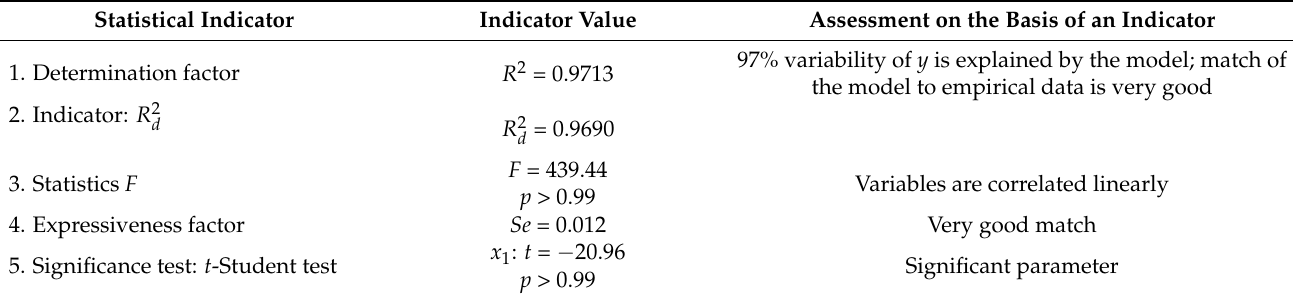
Figure 7. Presentation of the used model (1) and empirical data in the analysed field. Table 1. Basic statistical analysis of the model no. 1.